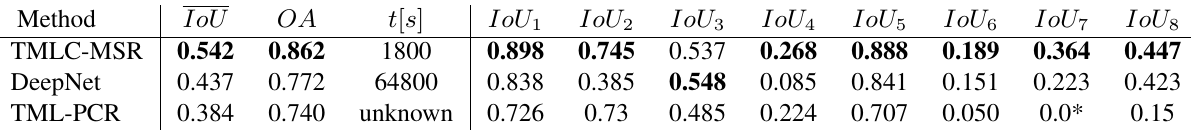
Table 2: Semantic3d benchmark results on the reduced data set: 3D covariance baseline TMLC-MSR , 2D RGB image baseline TML- PCR , and our 3D CNN baseline DeepNet . TMLC-MSR is the same method as TMLC-MS , the same goes for TMLC-PCR and TMLC- PC . In both cases R indicates classifiers on the reduced dataset. IoU for categories (1) man-made terrain, (2) natural terrain, (3) high vegetation, (4) low vegetation, (5) buildings, (6) hard scape, (7) scanning artefacts, (8) cars. * Scanning artefacts were ignored for 2D classification because they are not present in the image